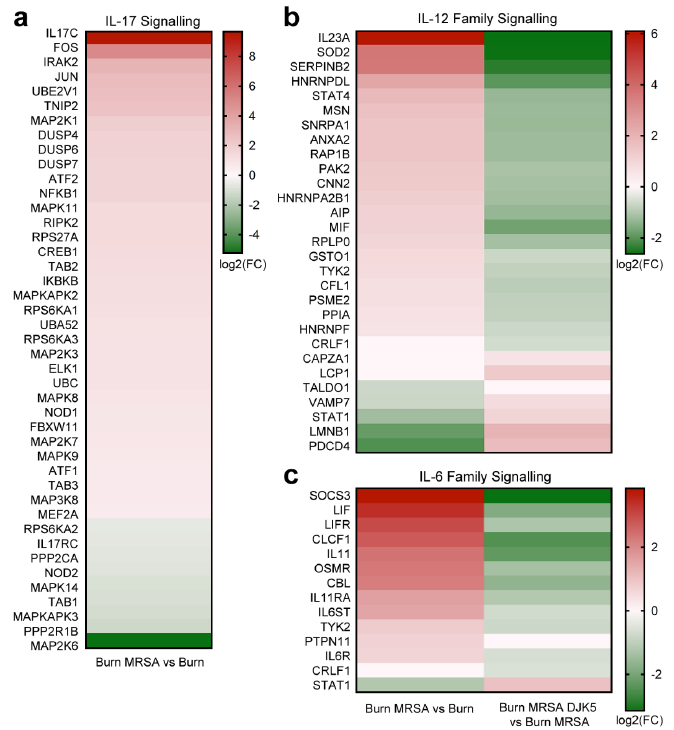
Figure 3. DJK-5 treatment downregulated IL-12 and IL-6 family interleukin responses in MRSA biofilm skin infection. Heatmaps of DE genes involved in the ( a ) IL-17, ( b ) IL-12 family ( c ), and IL-6 family signalling cascades in response to MRSA biofilm-induced skin inflammation with or without DJK-5 treatment. Color scale based on log 2 fold-change of DE genes with red indicating upregulation and green indicating downregulation.